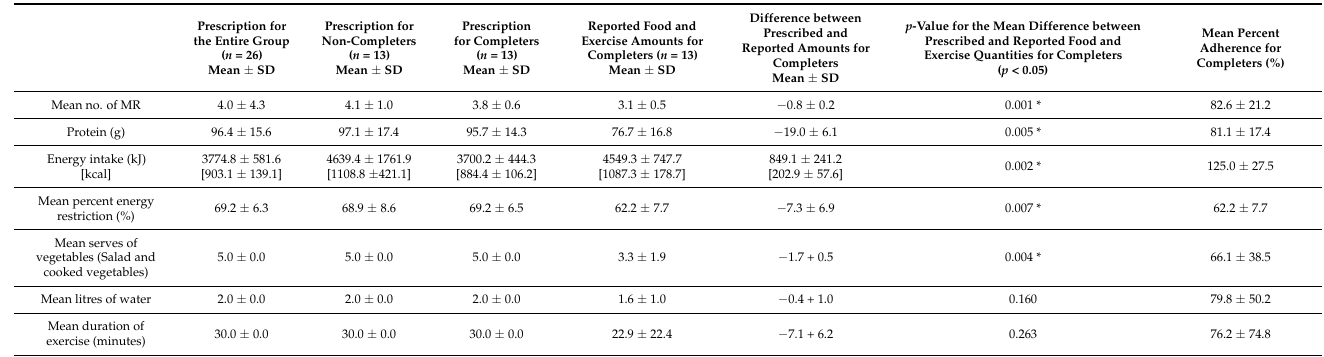
Table legend: SD; standard deviation, MR; meal replacement, * p -value of <0.005 denoting